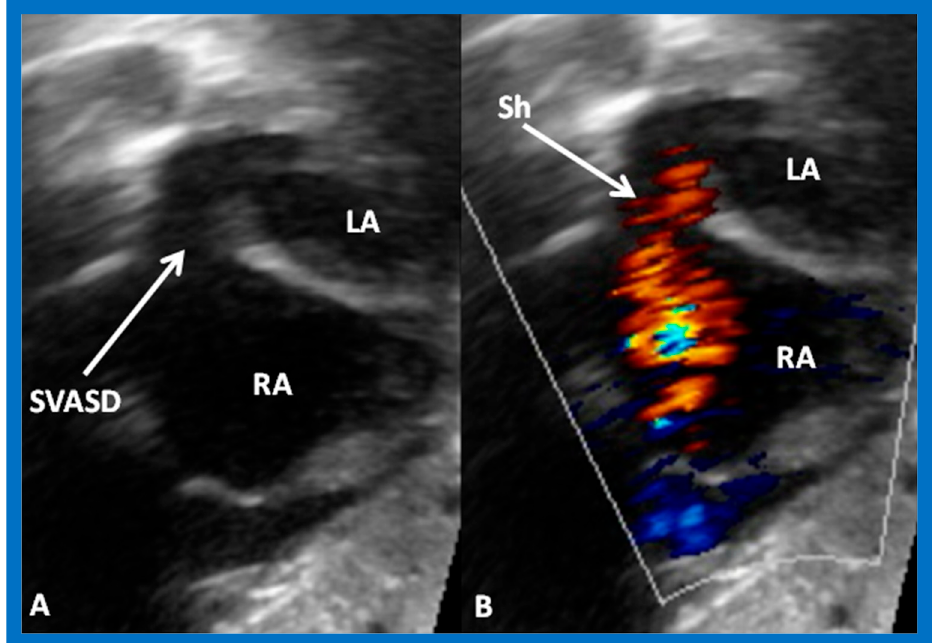
Figure 9. 2D ( A ) and color flow ( B ) images from subcostal views demonstrating a sinus venosus atrial septal defect (SVASD) in 2D ( A ) (arrow) with a shunt (Sh) from left to right (arrow in ( B )). Left atrium (LA) and right atrium (RA) are marked. Modified from Reference [6].